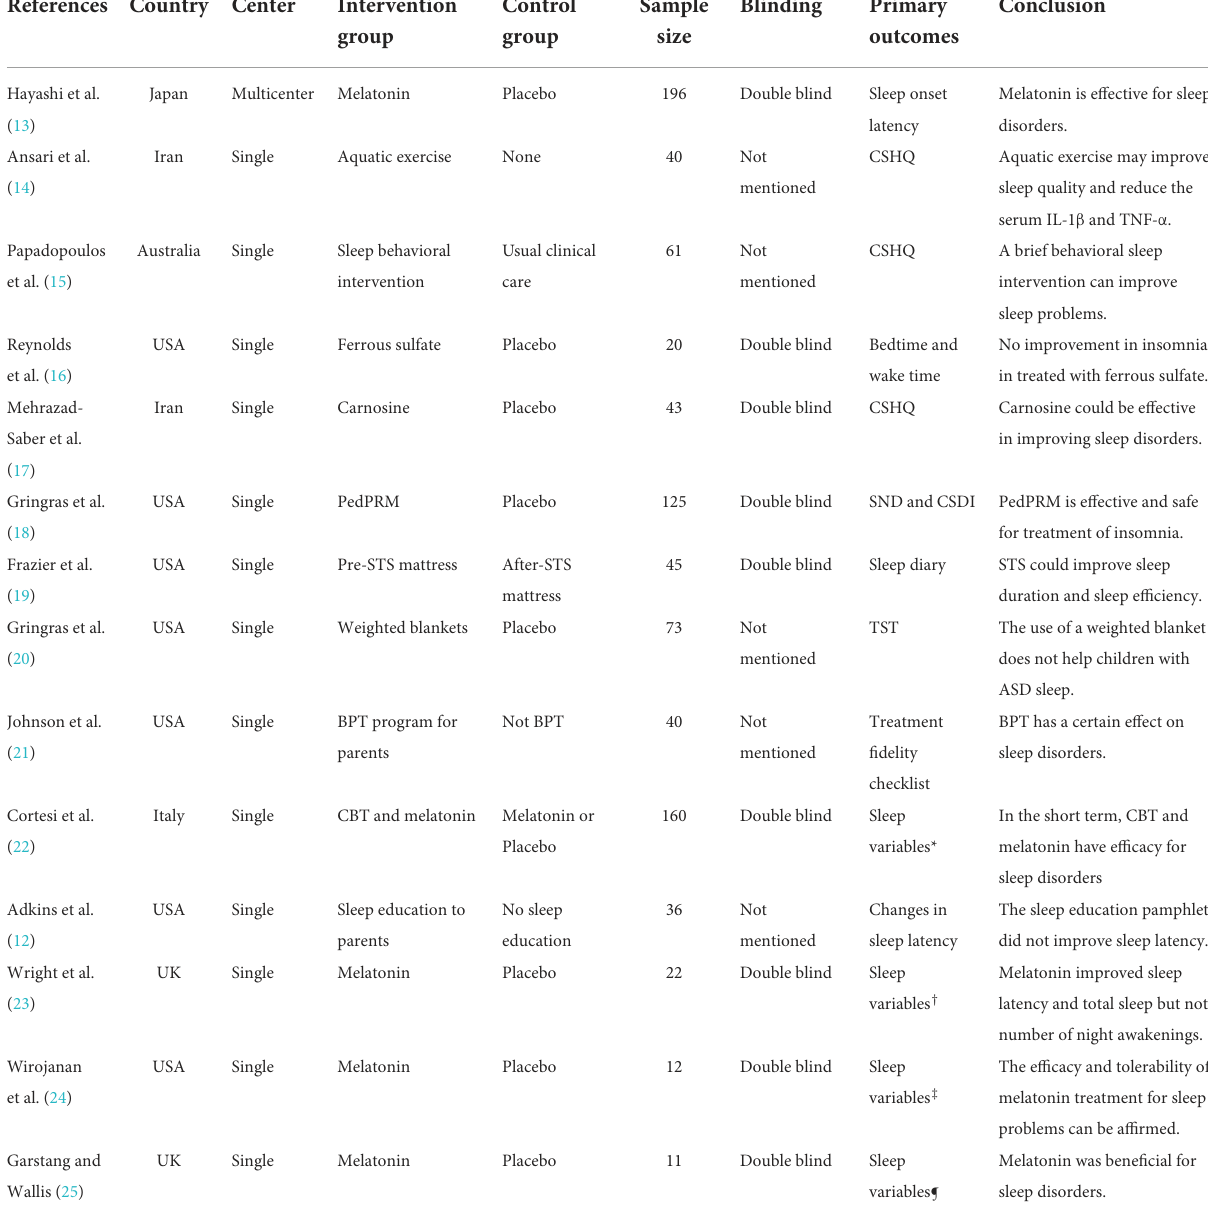
TABLE 2 Randomized controlled trials of sleep disorders in children with autism spectrum disorders. References Country